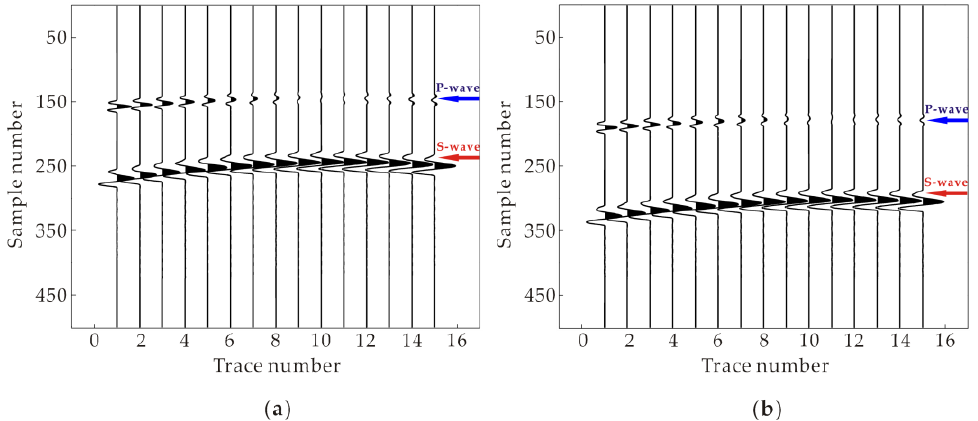
Figure 3. Z-component record section of the noise-free synthetic data for the ( a ) target and ( b ) reference events.